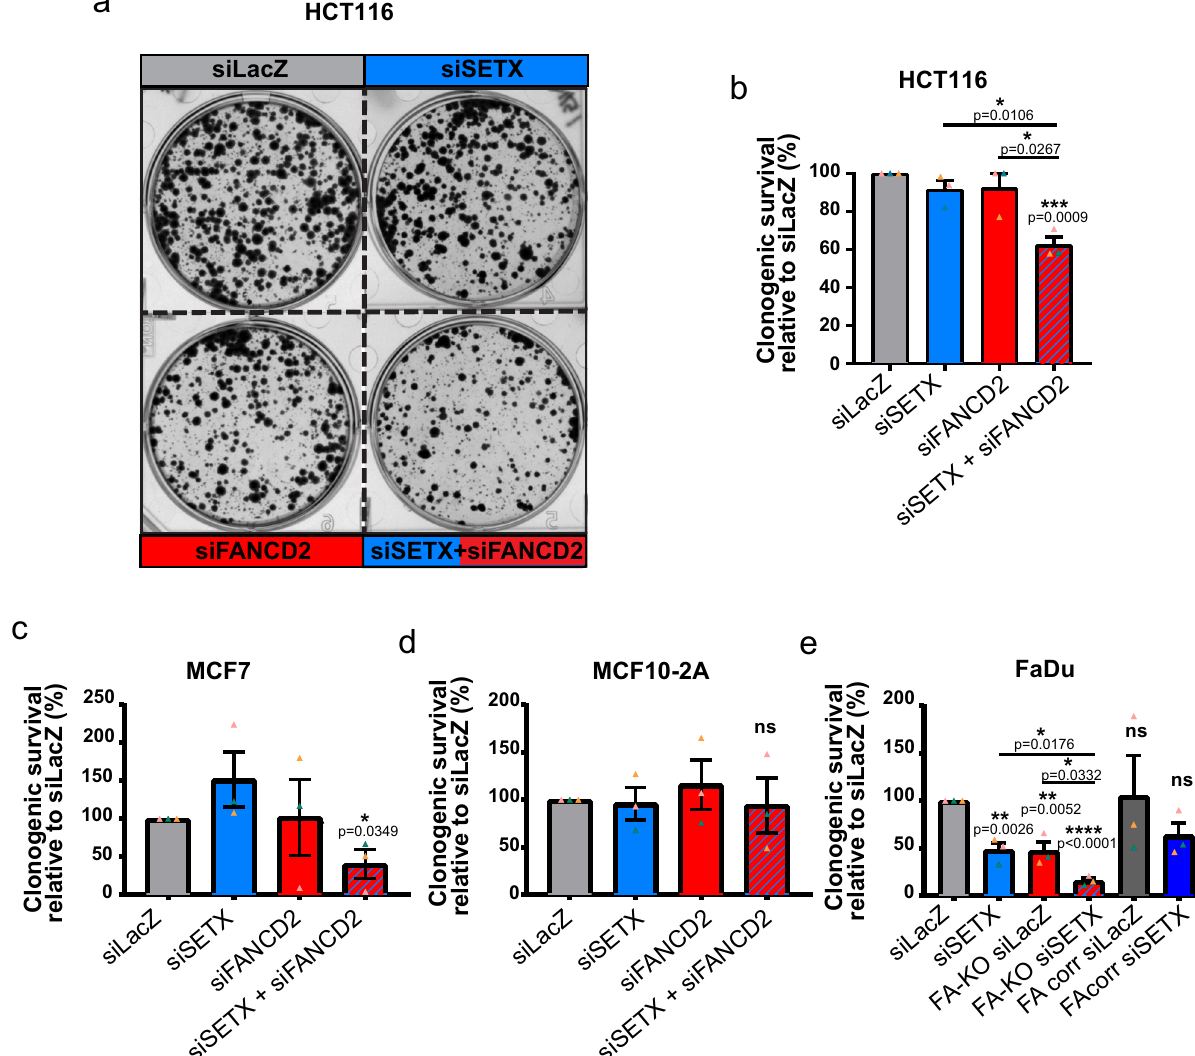
Fig. 5 FANCD2 and SETX co-depletion causes a synthetic proliferation defect in cancer cell lines. a Representative images of 6-well plates seeded with control (LacZ), SETX, FANCD2, and SETX and FANCD2 siRNA-transfected HCT116 cells and analyzed for clonogenic survival assays. Colonies were stained after 12 days with crystal violet. b Quanti fi cation of the colonies counted in SETX, FANCD2, and SETX and FANCD2 knockdown HCT116 cells relative to control. c Quanti fi cation of the colonies counted in SETX, FANCD2, and SETX and FANCD2 knockdown MCF7 breast cancer cells relative to control. d Quanti fi cation of the colonies counted in SETX, FANCD2, and SETX and FANCD2 knockdown MCF10-2A mammary epithelial cells relative to control. e Quanti fi cation of the colonies counted in LacZ or SETX knockdown FaDu, FaDu-KO (FANCA − / − ) or FA-corr (FA-KO + FANCA) head and neck carcinoma cells relative to control (siLacZ) FaDu